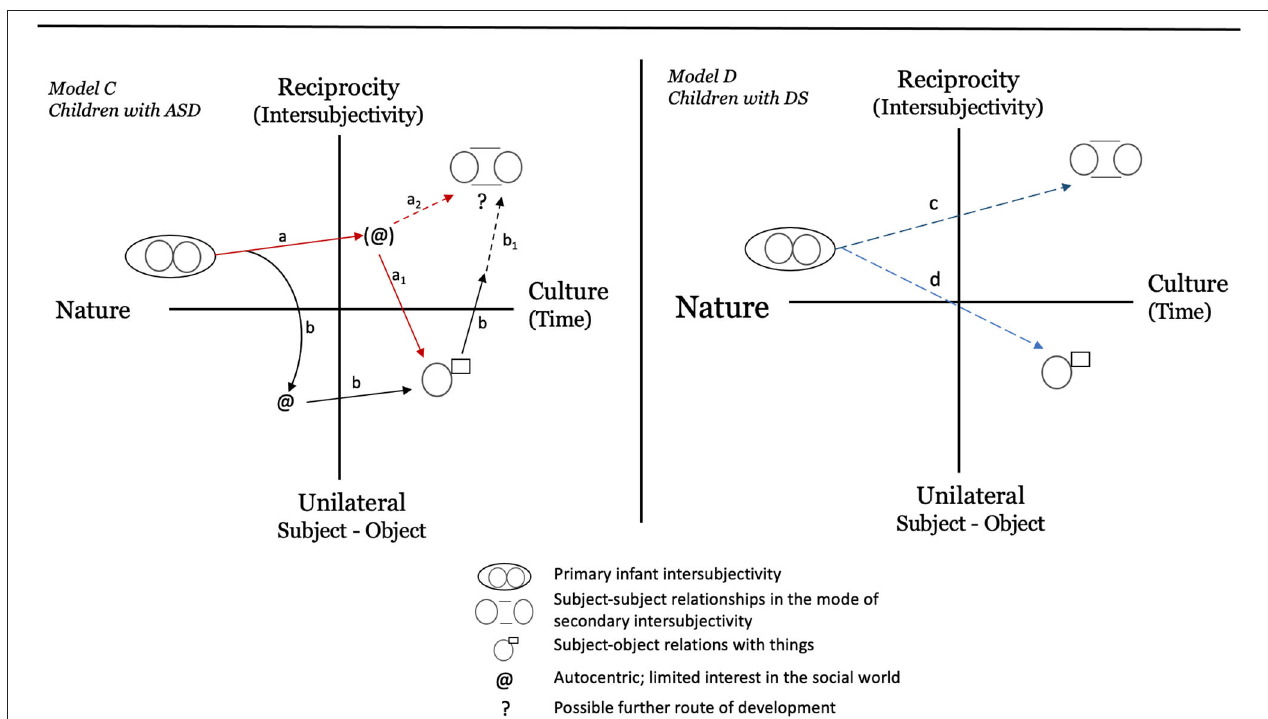
FIGURE 5 | Proposed new models based on the observations presented in the text. Model C represents ASD and Model D describes tentative paths for DS. Explanations of paths: Model C: (1) Path a depicts a child with autism developing along a typical trajectory over the first 12–18 months where after a halt in development takes place and the child loses social abilities previously mastered (indicated by path a 1 ). This child might eventually find a renewed social interest (maybe via an intervention) and move via path a 2 to develop a capacity for subject-subject relationships. (2) Path b depicts a child lagging behind in social ability already during the first year but note that even this child has the capacity for primary intersubjectivity at birth. The child might stay in a mindset that is occupied with subject-object relations but may also later move toward the social world (illustrated by b 1 ). Model D: Paths c and d are almost identical to the paths in the original model presented by Bråten (1996) for typically developing children. As in Model C, the infant has the ability to act in a complementary way and the participants step into each other’s dialogic circle already from the start. The figure also illustrates different developmental paths for relations with people as compared to objects. The main difference from Bråten’s original model is that instead of solid lines, the lines here are dashed in an attempt to illustrate that children with DS usually show a slower pace of development and might not reach the expected end